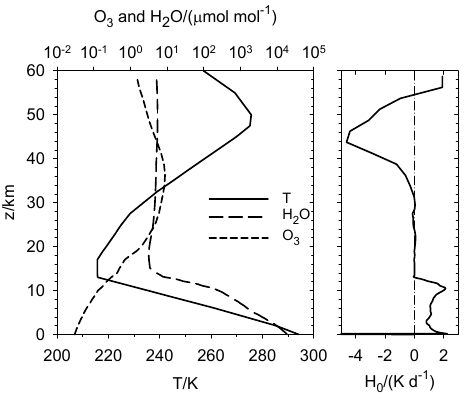
Figure 1. Temperature T of the midlatitude summer standard atmo- sphere versus height z , together with water vapor and ozone mo- lar mixing ratio (O 2 : 0.2002molmol − 1 ; CO 2 : 360µmolmol − 1 ) , and heating rate H 0 = Q 0 /(ρc p ) keeping the atmosphere at steady state. Because of TOA radiative imbalance, H 0 is strongly negative at the surface; in the mass-weighted average, H 0 = − 1 . 25Kday − 1 in the troposphere and − 0.057Kday − 1 in the stratosphere, balanc- ing the summer